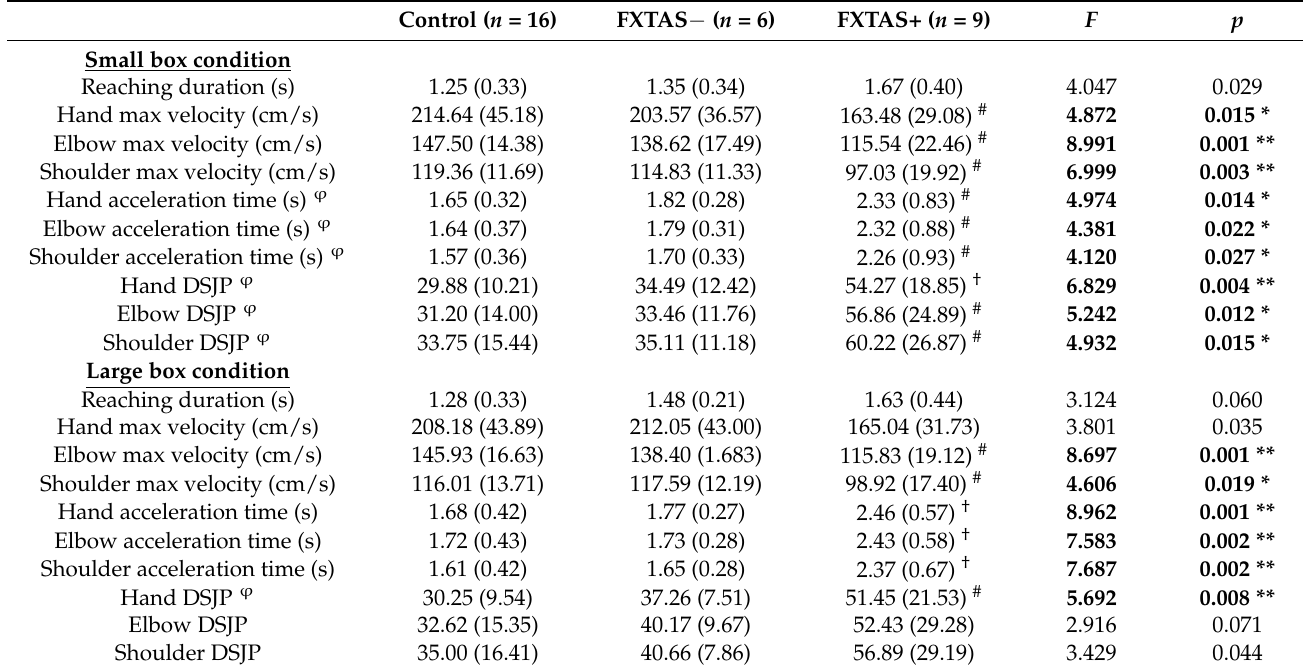
Table 3. Reaching outcomes (mean (SD)) during dynamic walking trials for the healthy controls and premutation carriers with and without